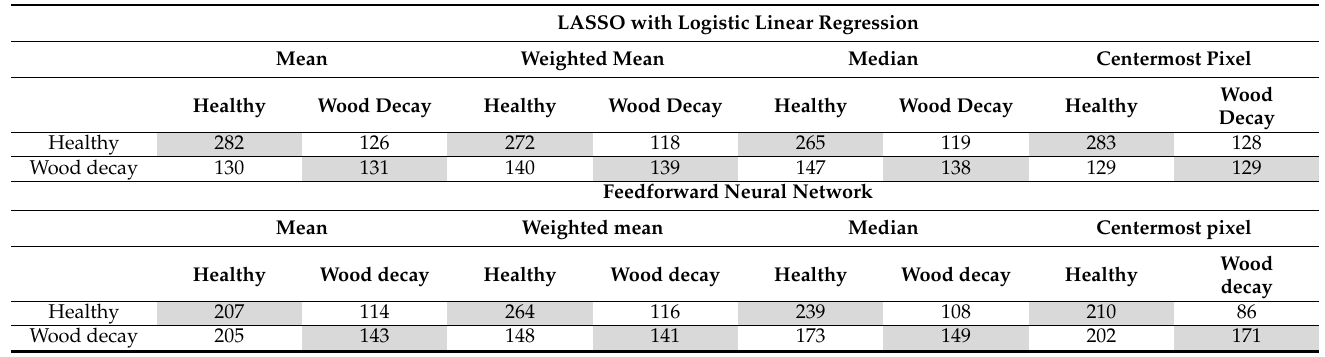
Table 6. Confusion matrices of the models with pixel aggregations for Dataset II. The cells with gray background are the main diagonal of the confusion matrices.